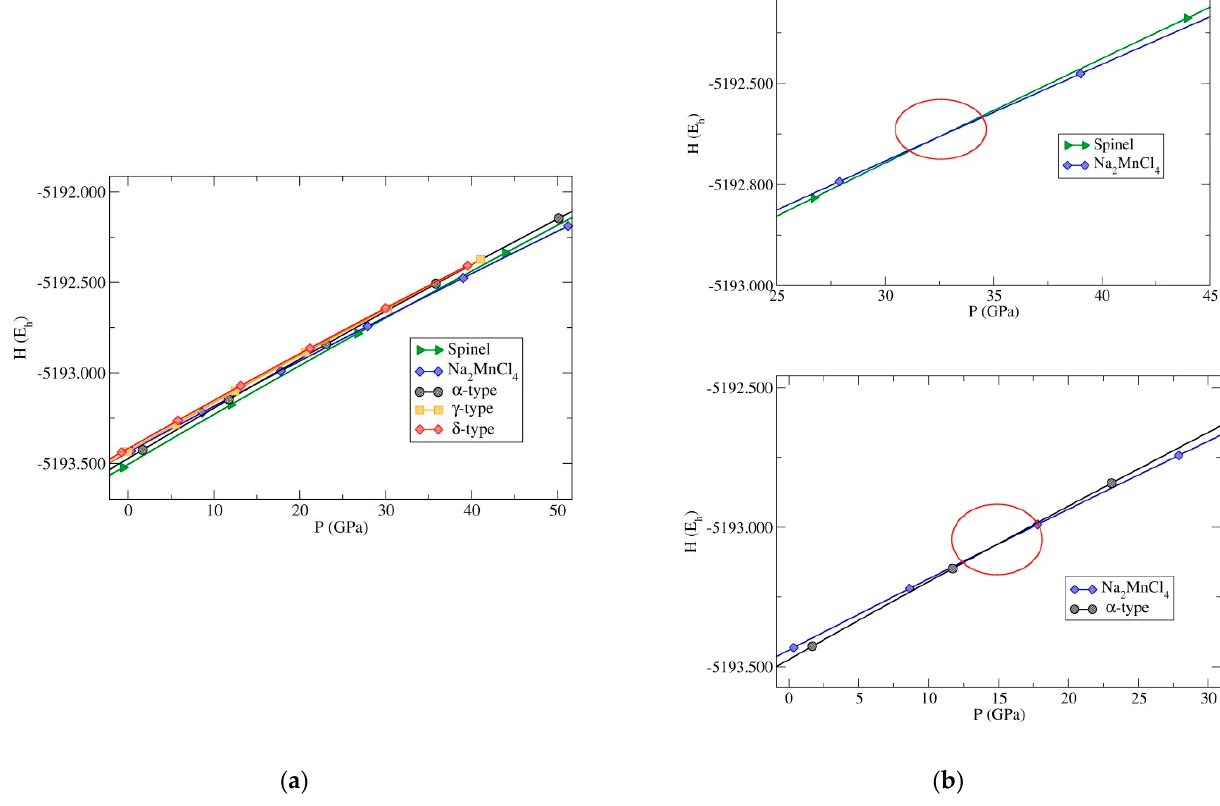
Figure 13. (a) Enthalpy vs. pressure, H(p), curves computed for the five most relevant structures, including the high- pressure region. (b) Plots on the right side show H(p) curves focused on two transitions. Top: H(p) curves for the spinel- and the Na 2 MnCl 4 -type (transition pressure was found to be ~33 GPa); Bottom: H(p) curves between the Na 2 MnCl 4 -type and the α -Cr 2 SiN 4 -type modifications (transition pressure would be ~15 GPa). The calculations were performed using the GGA-PBE functional and the energies per formula unit are given in Hartree (E h ).